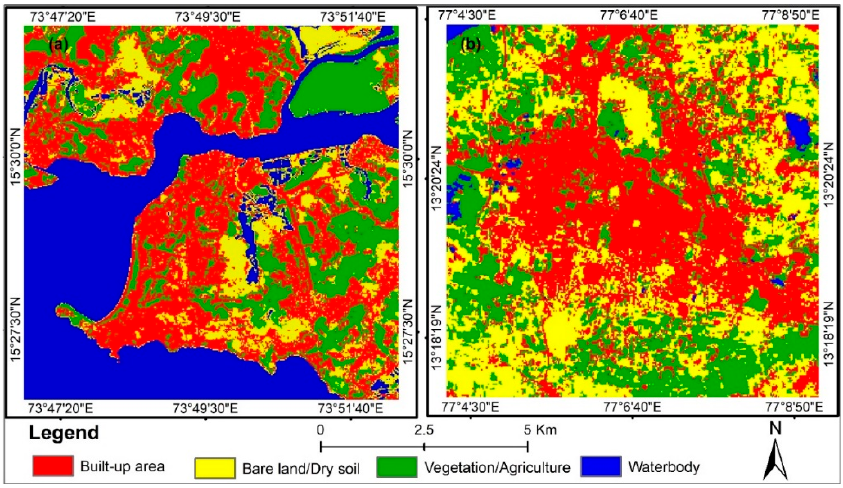
Figure 5. Land use/land cover profile of Panaji ( a ) and Tumkur ( b ). Figure 5. Land use / land cover profile of Panaji ( a ) and Tumkur ( b